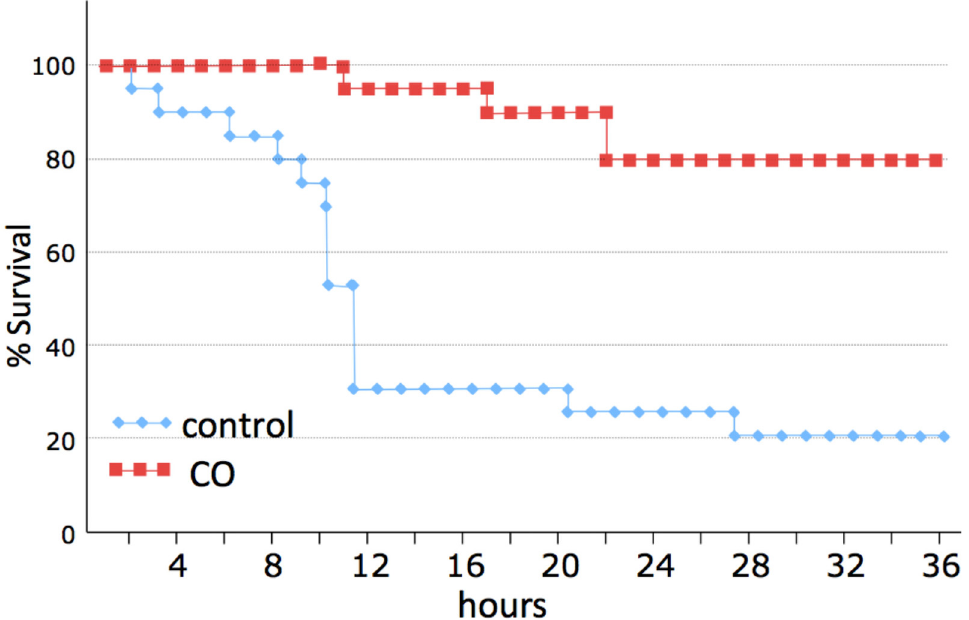
Fig 1. CO therapy protects against mortality in a model of murine hemorrhagic shock and resuscitation. A severe hemorrhagic shock and resuscitation model resulted in 80% mortality by 36 hours. CO therapy (250 ppm) limited mortality to 20% (P < 0.05). Kaplan-Meier method was used to compare